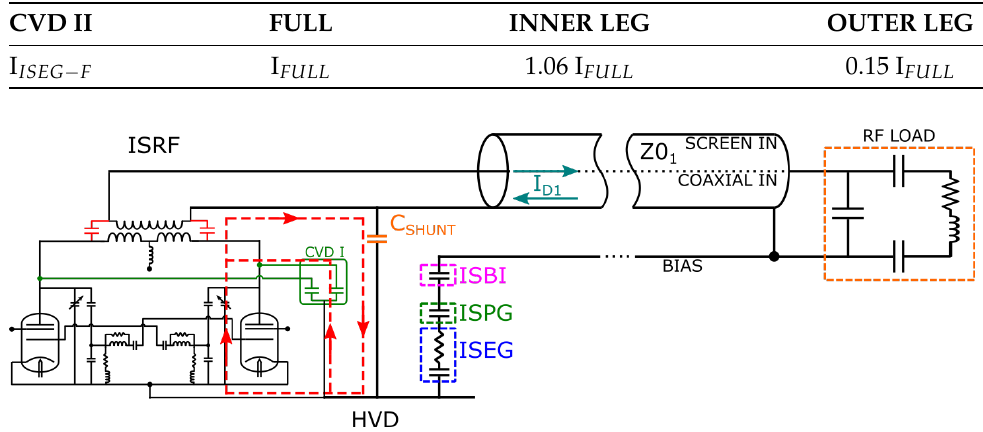
Table 2. Simulation of current through ISEG filter in different CVDII configurations: the connections of only inner and outer leg of the CVD are tested against the full CVD.